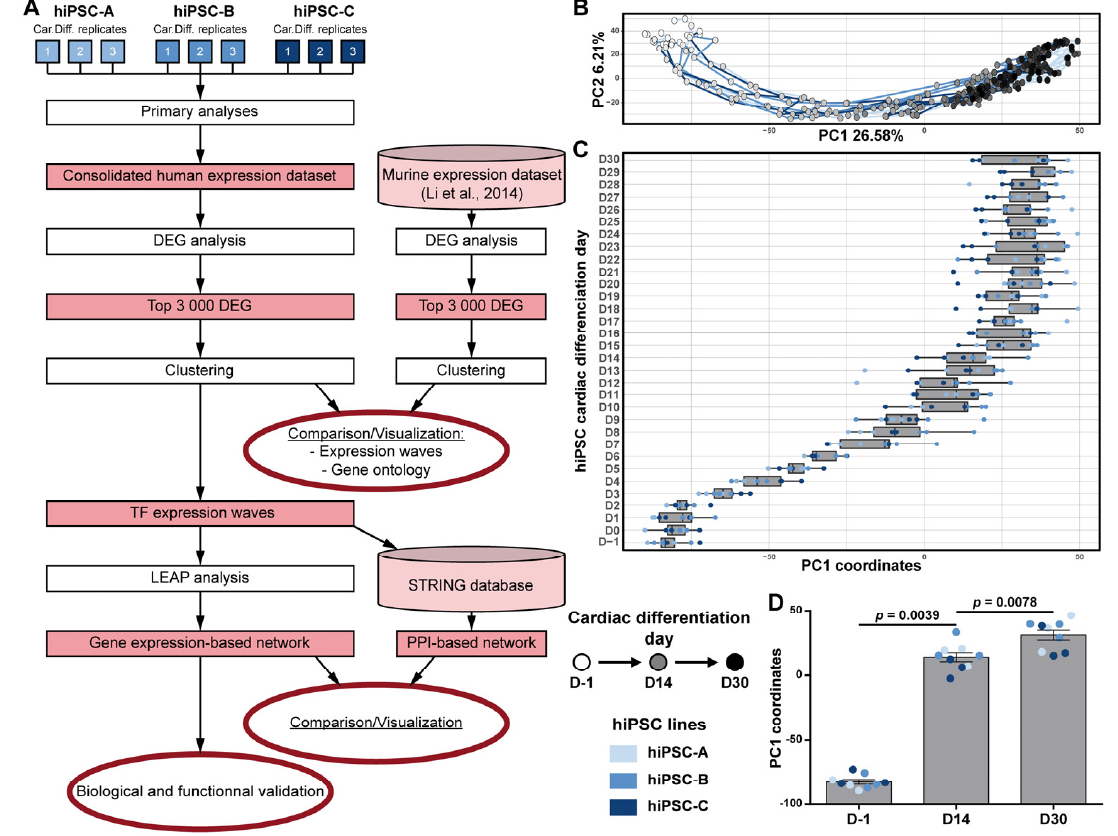
Figure 2. Transcriptomic time-course analysis of hiPSC cardiac differentiation. ( A ) Methodological workflow. Steps are represented in white rectangle and outputs in red rectangles. ( B ) Global transcriptomic variations displayed with the first two components of the Principal Component Analysis. Three cardiac differentiations were studied for each of the three hiPSC lines. For each cardiac differentiation, a line connects the time-points in chronological order. ( C ) Boxplots displaying the distribution of PC1 coordinates of each replicates at each day (median ± quartile). ( D ) Histogram comparing distribution of PC1 coordinates at the beginning (D-1), the middle (D14) and the end (D30) of hiPSC cardiac differentiations (Mean ± SEM; Wilcoxon matched-pairs signed rank test).